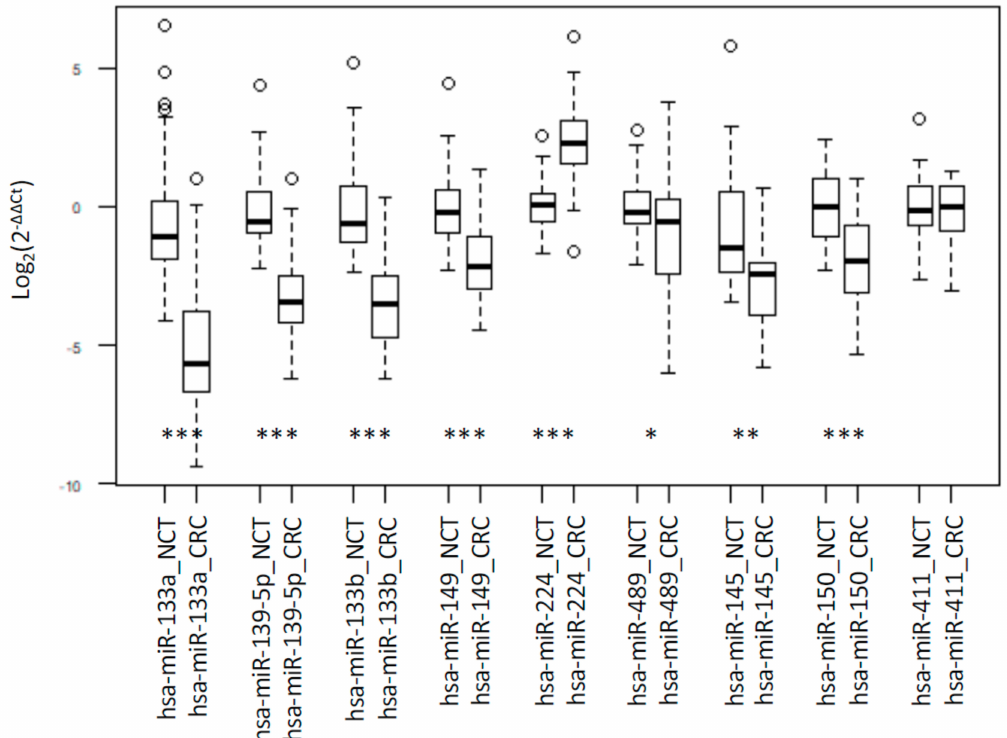
Figure 2. Box plot of RT-PCR results. RT-PCR quantification of miRNAs. The box border represents the interquartile range, the horizontal line in the box is the median, and circles represent outliers. Values are expressed as Log2(2 − ∆∆ Ct ). *, ** and *** represent significant di ff erences between CRC and NCT at p value < 0.05, < 0.01 and < 0.001, respectively. Table 1. Correlation between miRNAs expression levels.